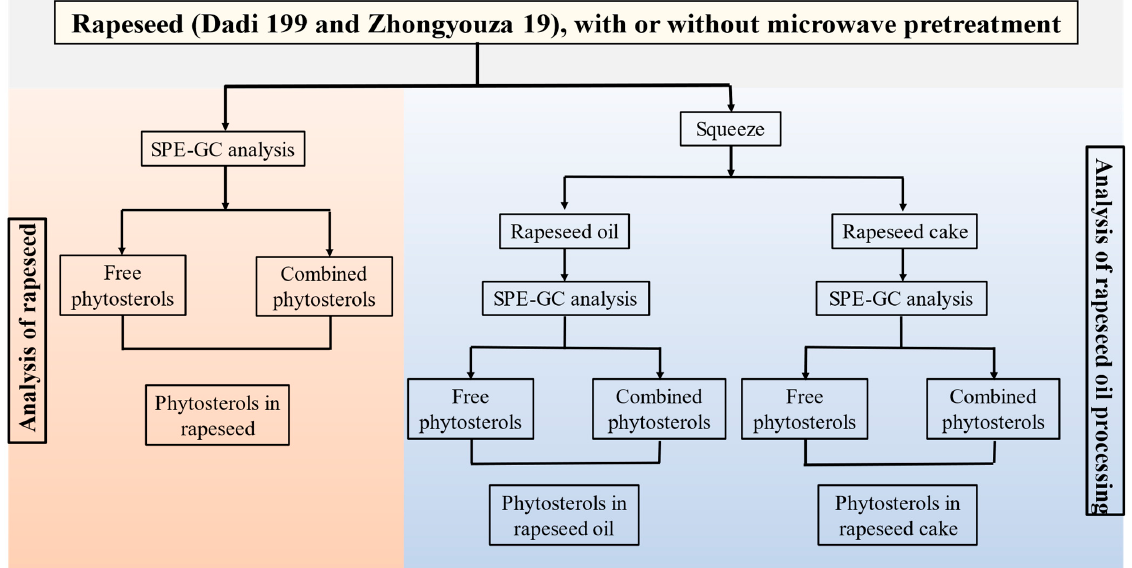
Figure 2. Schematic diagram for analysis the content of free and combined phytosterols in